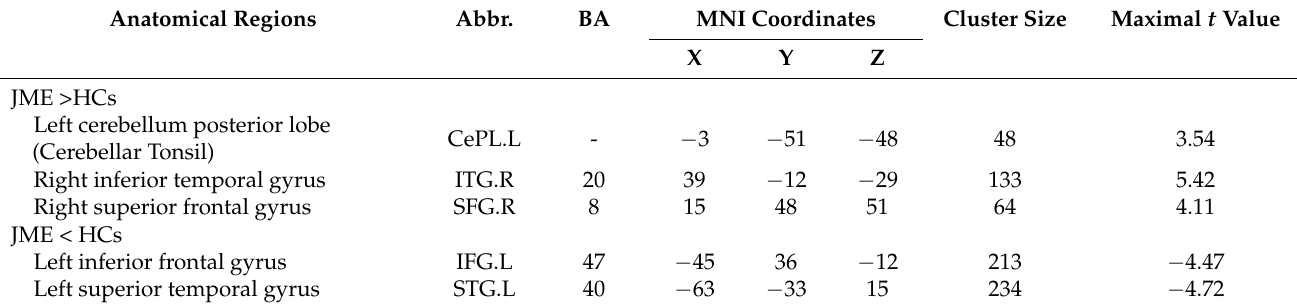
Table 2. Brain areas showing significant differences in DC between patients with JME and HCs.